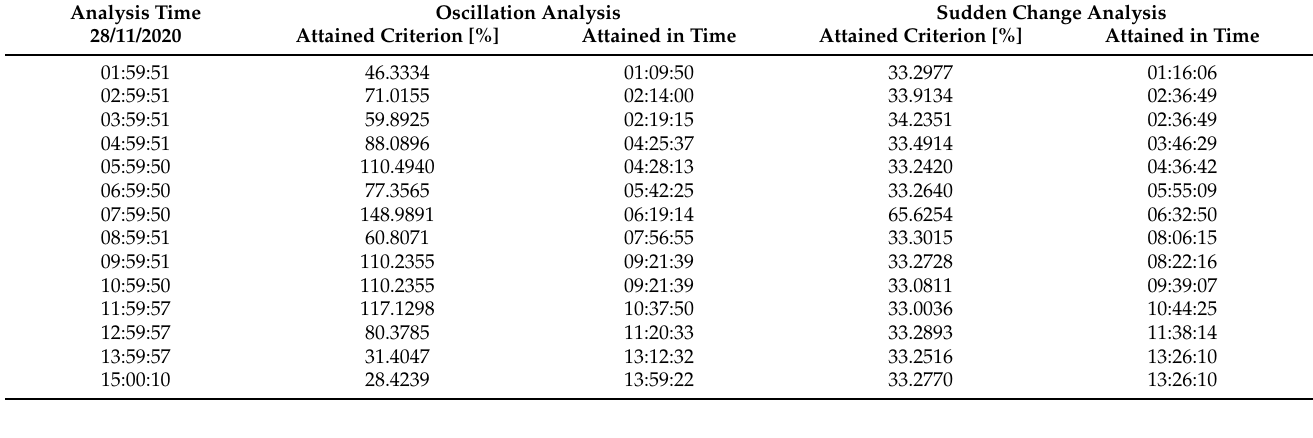
Table 2. Numerical results of cfn:: TC T15.3_out0 variable.